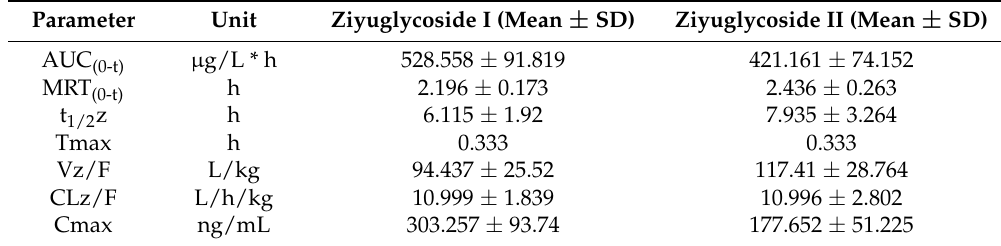
Table 8. Pharmacokinetic parameters of ZGS1 and ZGS2 in rats after subcutaneous injection administration of 10 mg/kg ZGS1 ( n = 5).